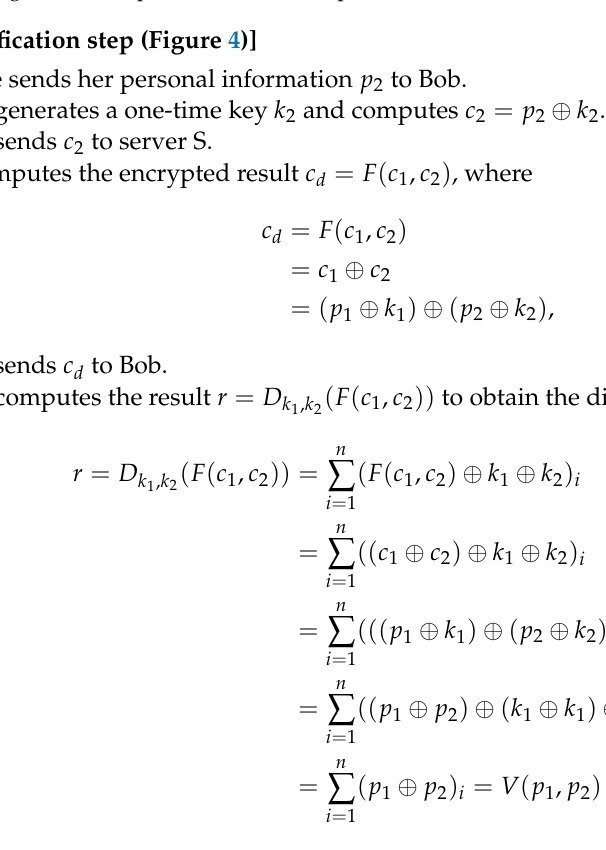
Figure 3. Registration step with the one-time pad.